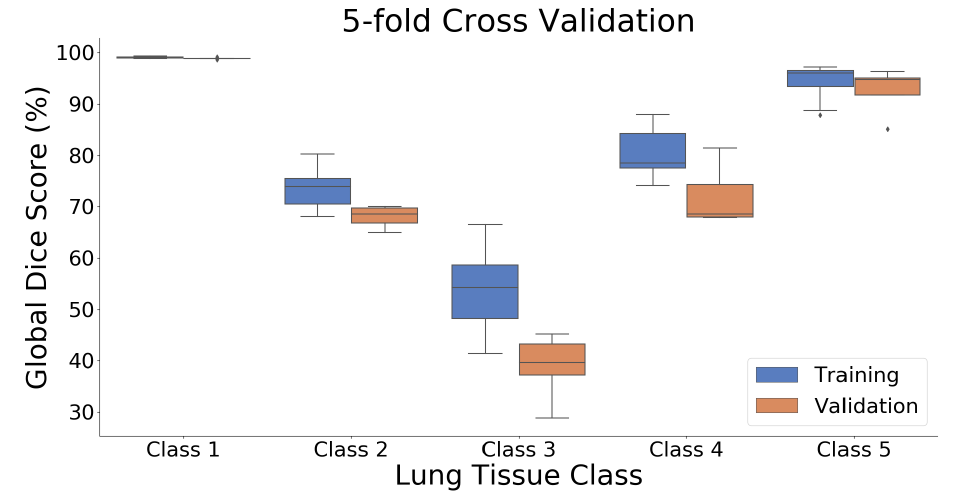
Figure 3. Box plot of global Dice (in %) scores for 5-fold cross validation on the development dataset for five tissue classes. The global Dice distribution is shown with respect to the folds. Table 5. We present details of the 5-fold cross validation experiment, with the mean , std , and lower and higher confidence intervals ( ci 95 lo , ci 95 hi ) corresponding to Figure